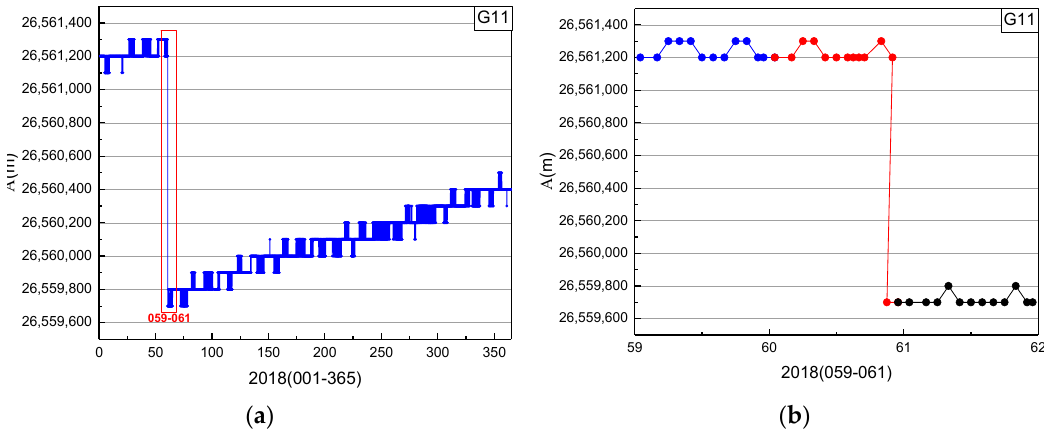
Figure 14. Time series of orbital semimajor axis of G11 in 2018: ( b ) detailed information of the red box (days 059–061) in ( a ).